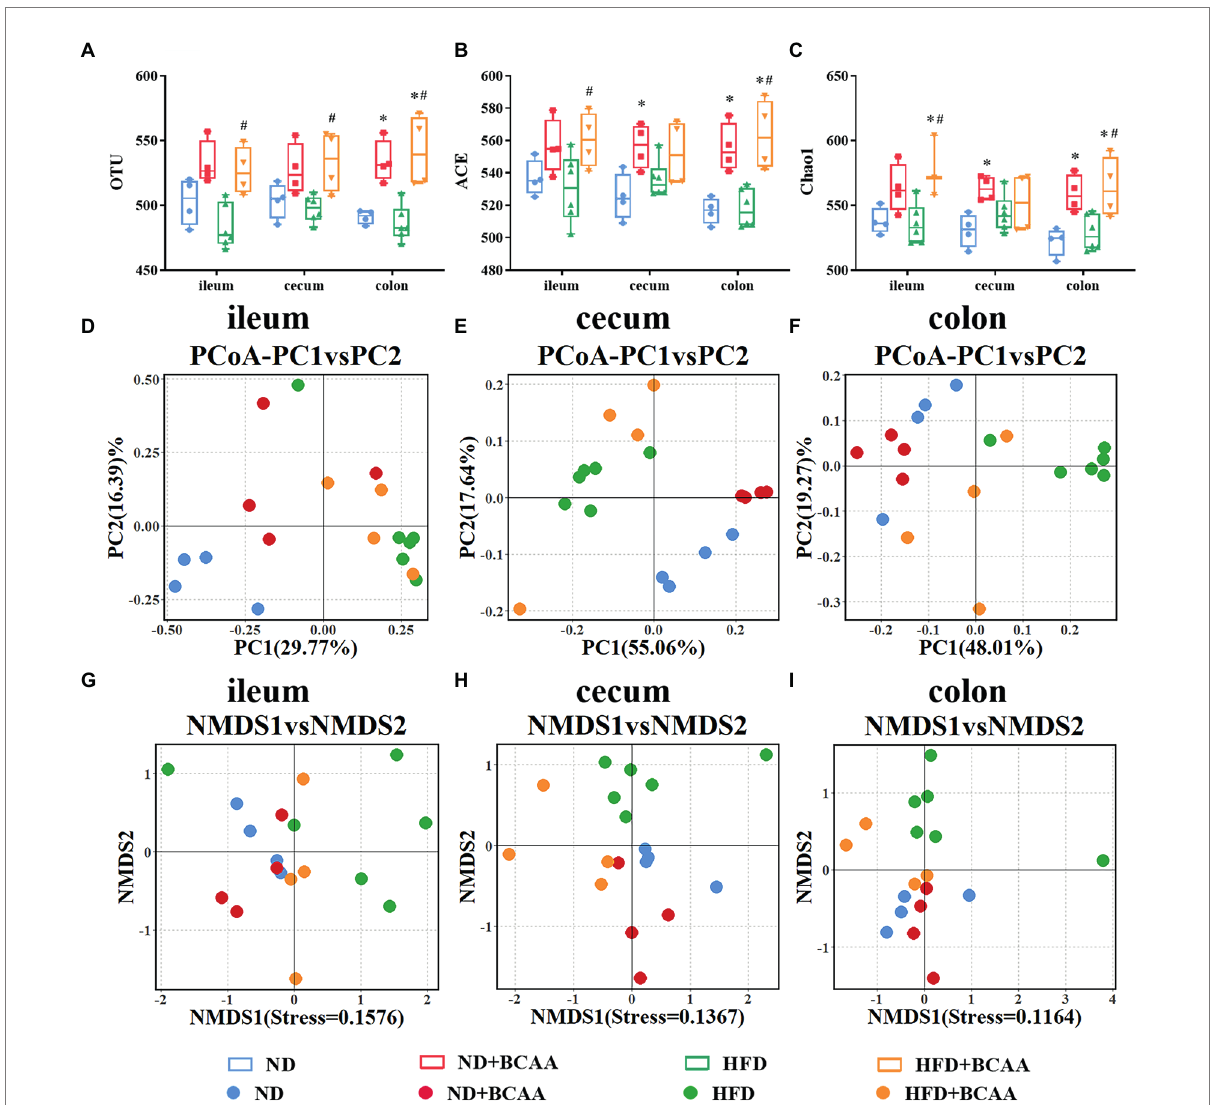
FIGURE 6 Effect of BCAAs supplementation on gut bacterial diversity. (A) operational taxonomic unit (OTU), (B) ACE, and (C) Chao1 analyses of the gut bacteria from different parts of the gut in the indicated groups. (D–F) Principal coordinate analysis (PCoA) analysis of the microbiota composition. (G–I) Nonmetric multidimensional scaling (NMDS) analysis of the microbiota composition ( n = 4 for the ND, ND + BCAAs, and HFD + BCAAs groups, n = 6 for the HFD group). * p < 0.05 vs. the ND group; # p < 0.05 vs. the HFD